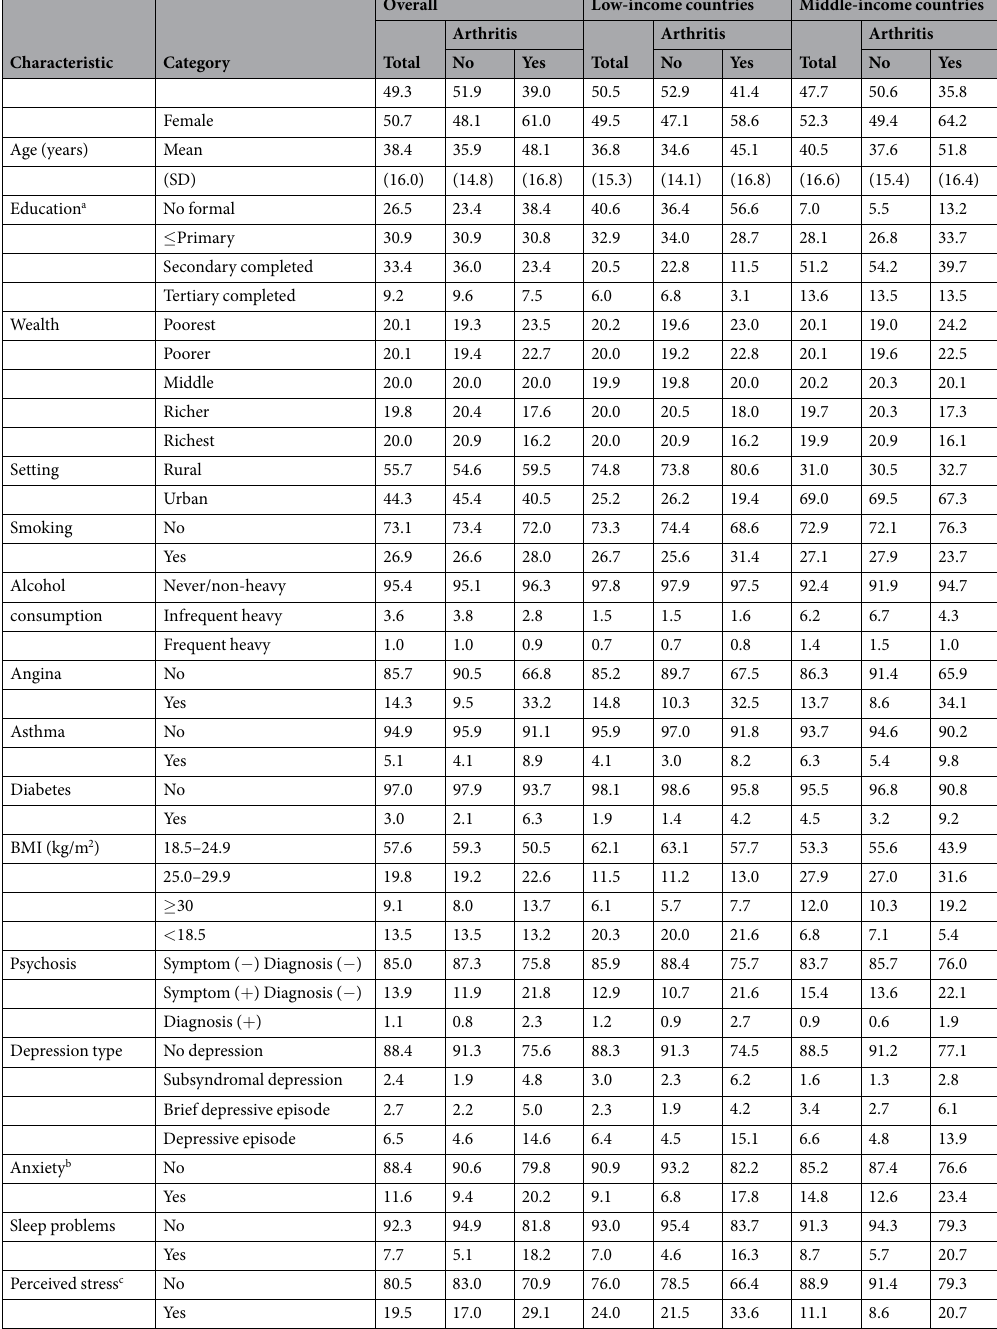
Table 2. Sample characteristics (overall and by country-income level and the presence of arthritis). Abbreviation: SD standard deviation; BMI body mass index. Data are % unless otherwise stated. All estimates are based on weighted sample. a Turkey is not included as it lacked information on education. b Morocco is not included as it lacked information on anxiety. c Brazil, Hungary, and Zimbabwe are not included as they lacked information on perceived